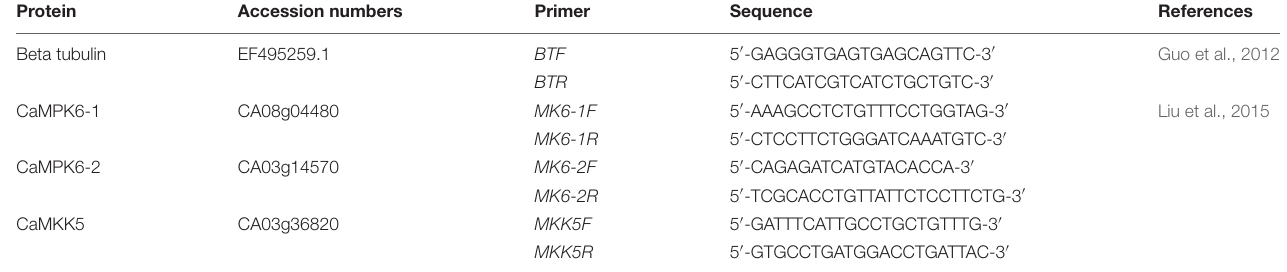
TABLE 1 | Primers for qRT-PCR amplifications.